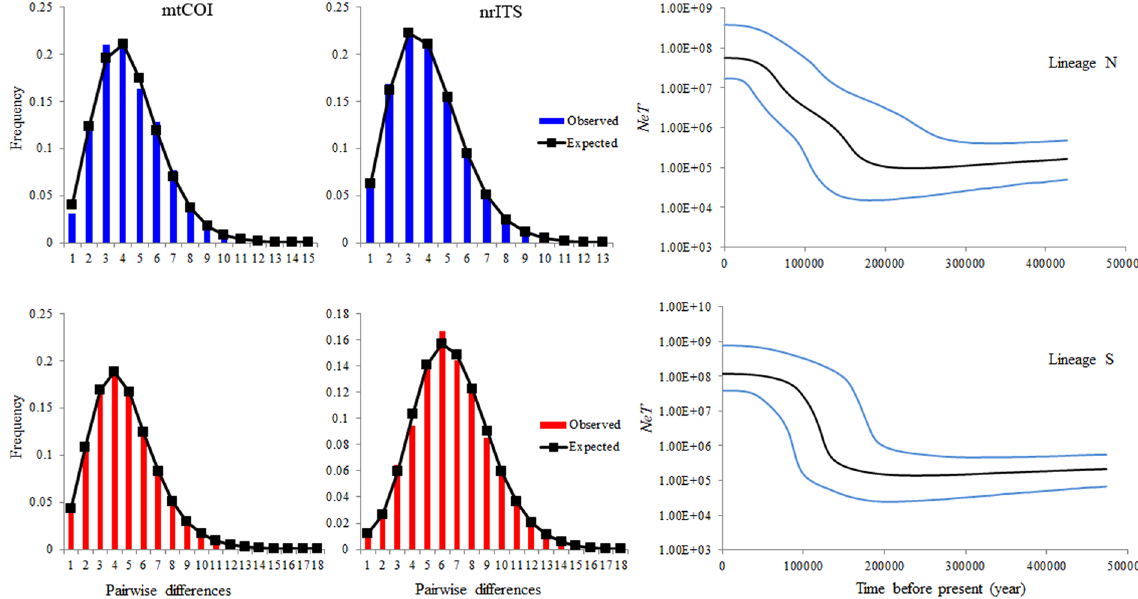
Figure 3. Mismatch distributions and Bayesian skyline plots for each genetic lineage. In mismatch distributions, bars represent the observed frequency of pairwise differences, whereas the solid lines show the expected values under the sudden expansion model. The BSPs show N e T ( N e = effective population size; T = generation time) changes through time. Black lines represent median estimates while the blue lines show the 95% highest posterior density (HPD)